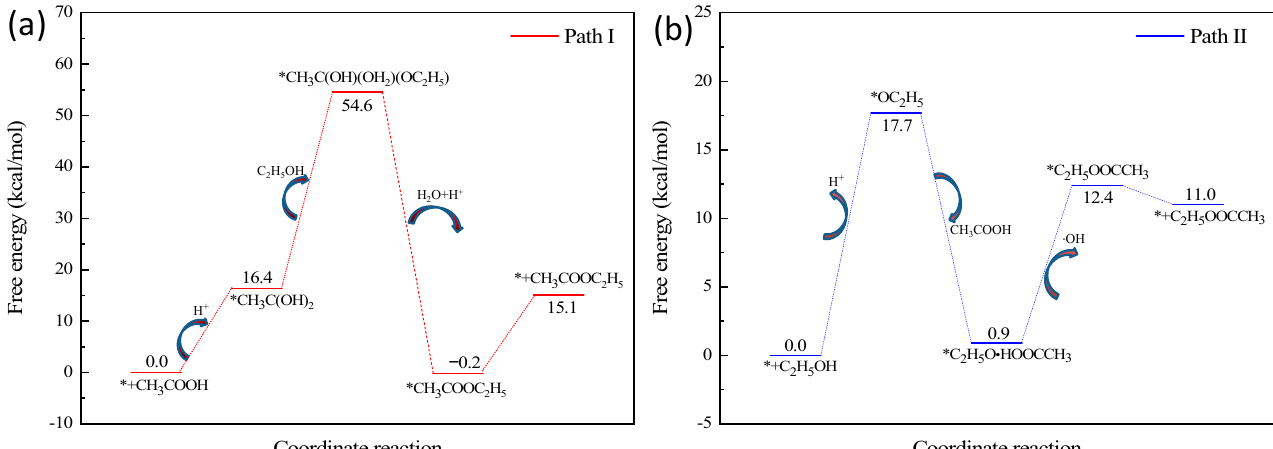
Figure 4. Calculation result of the transition state energy of the carbonium ion formed process ( a ) and free radical formed process ( b ). The asterisk (*) represents the active sites on the electrode’s